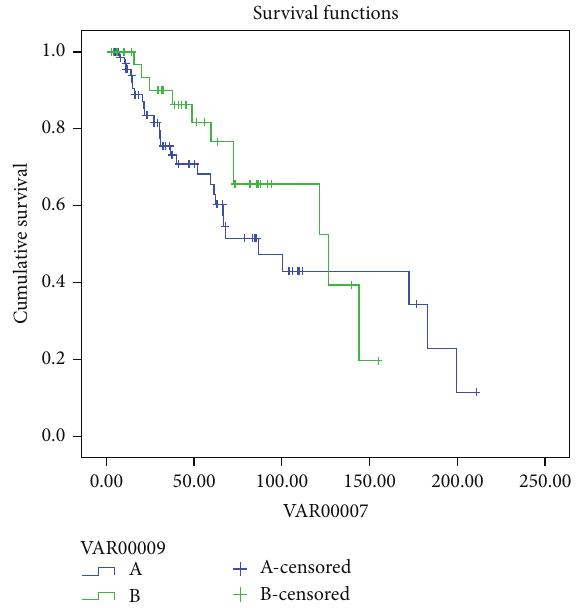
Figure 1: Patients survival PDF (green) and HDPD (blue) (log rank 𝑃 = 0.33 ).